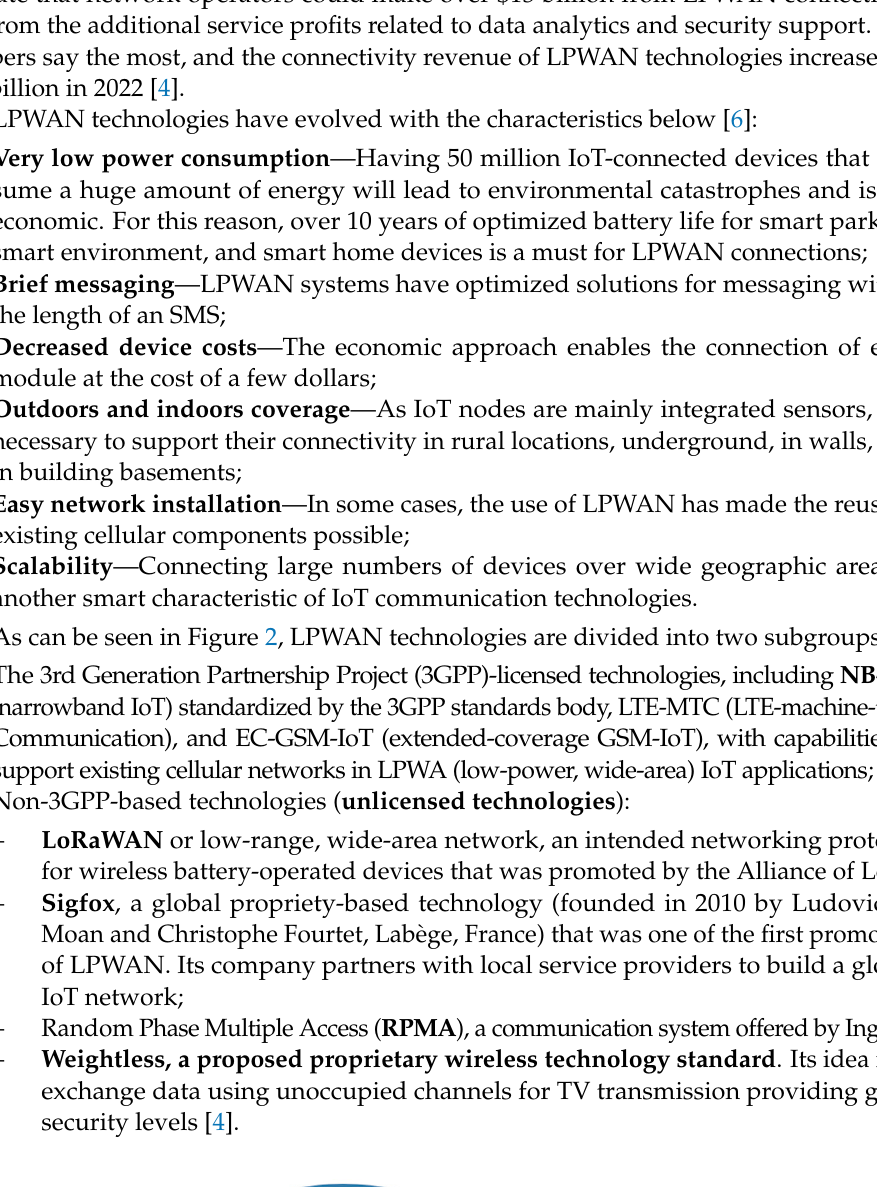
Figure 1. Comparison of wireless communication technologies. LPWAN technologies consume less battery power while working over long ranges.